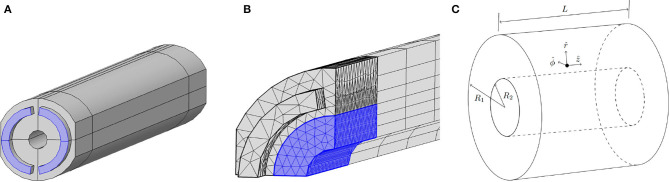
(A) Optimal design of the flow channel for the PDFS. The blue semi-annulus shaped regions represent the inflow tubes and the hollow cylinder in the center represents the outside of the fiber. The lines that partition the channel in quarters indicate the symmetry planes of the geometry and show that the channel can be partitioned into four equal parts. The development length that is considered for mesh refinement is indicated with the lines around the outside of the flow channel. Compared to the existing experimental design, shown in Figures 1A,C, all dimensions are decreased: the fiber radius here is 0.25mm, the flow channel radius is 1.1mm, the length of the device is still 2.5cm and the fiber is placed concentrically in the flow channel. Detailed dimensions can be found in the Supplementary Material. (B) The mesh that is used to compute the velocity profile numerically in the optimal geometry. Only the first 8mm of the region near the inlet is shown here; the mesh is similar near the outlet. The blue region indicates the domain near the fiber where the mesh is refined. Note that to speed up computation only a quarter of the device is meshed, exploiting the symmetries in the system. To retrieve the full velocity profile in the PDFS, we could then mirror our solution. (C) Concentric cylinders with inner radius R2, outer radius R1, and length L. The unit vectors (ẑ,r^,ϕ^) in cylindrical coordinates are depicted at a point between the cylinders, where the fluid will flow in the ẑ direction. The inner cylinder represents the outside of the cell layer. This geometry is used to approximate the PDFS; a comparison in terms of shear stress between the two geometries is described in section 3.4.